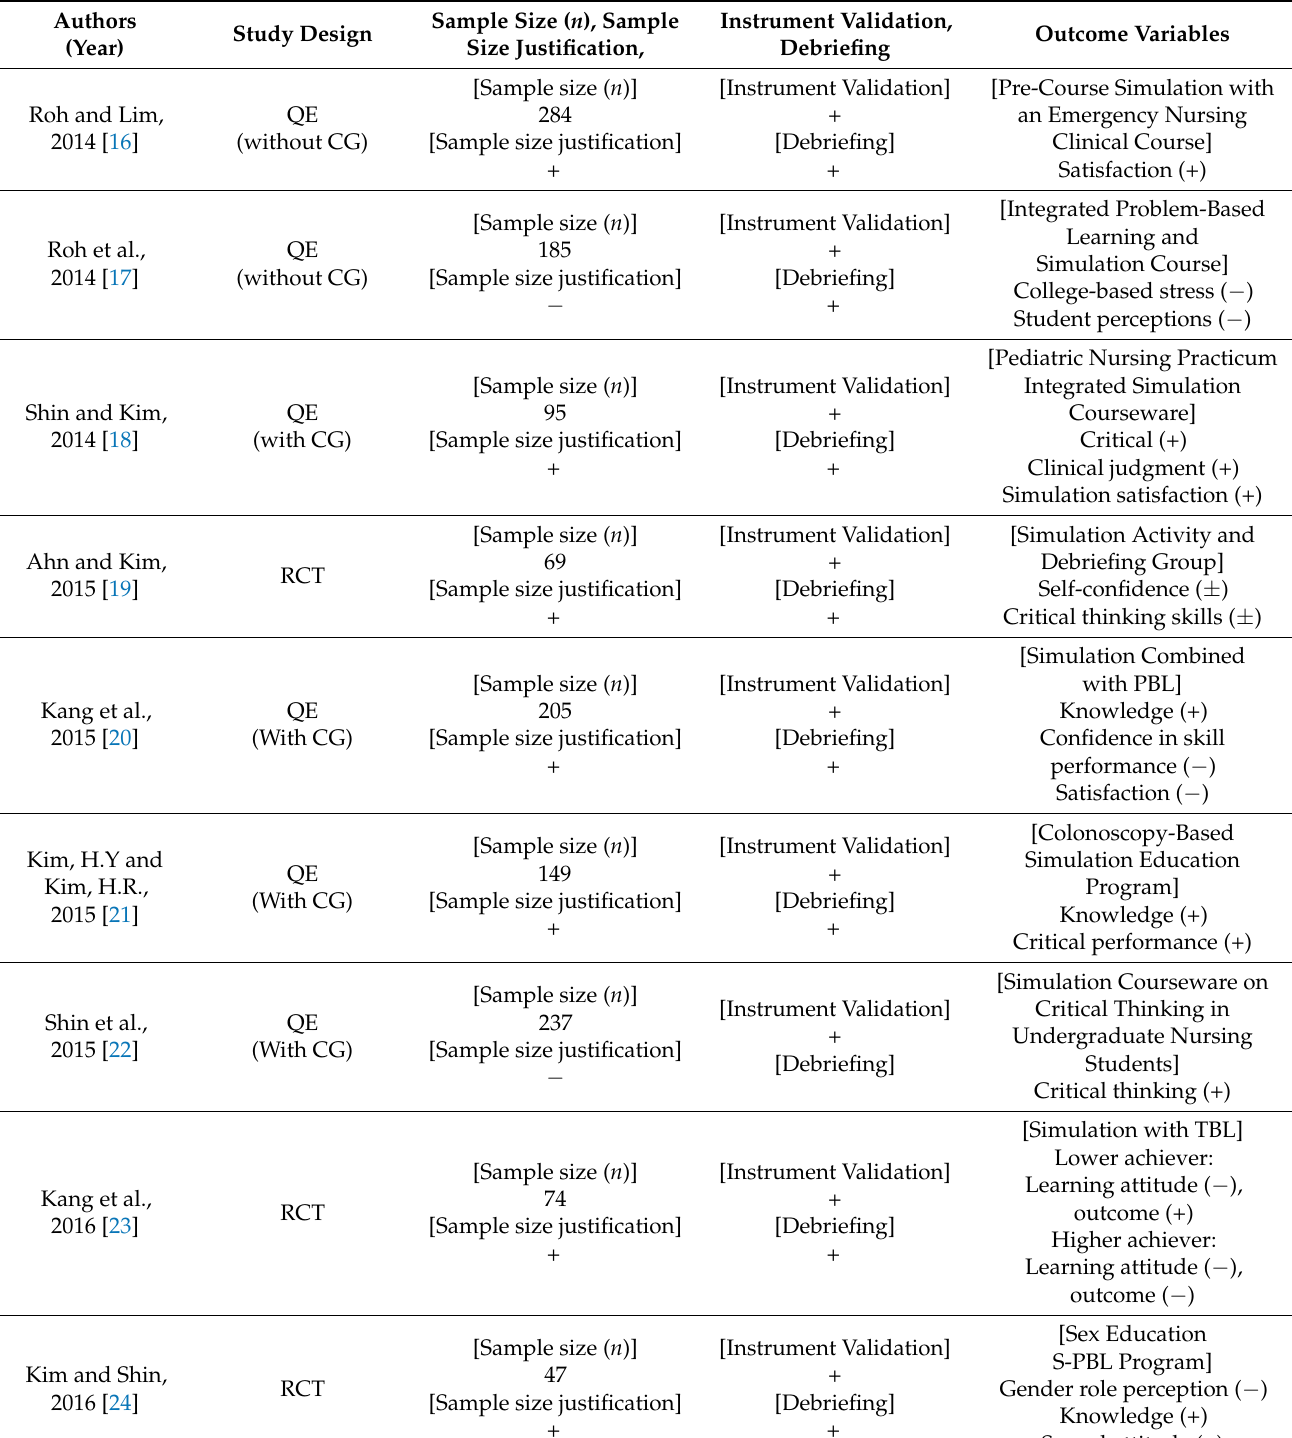
Table 1. Goal and design, measured variables, mediation, and